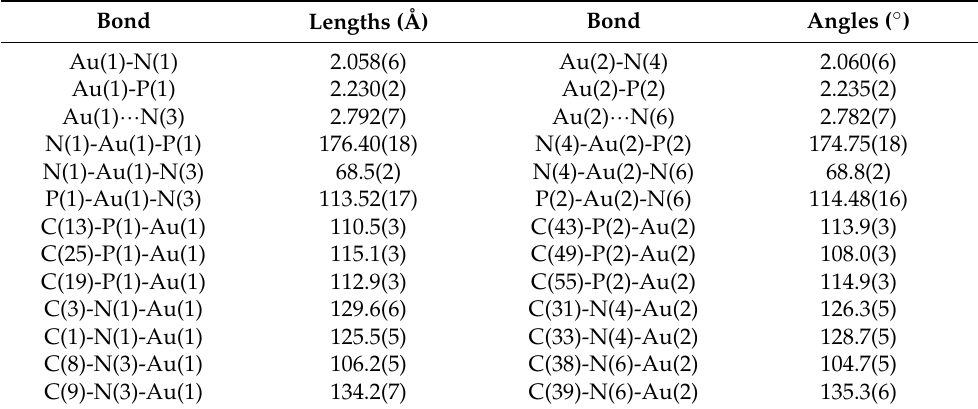
Table 1. Selected bond lengths (Å) and angles ( ° ) for 1.